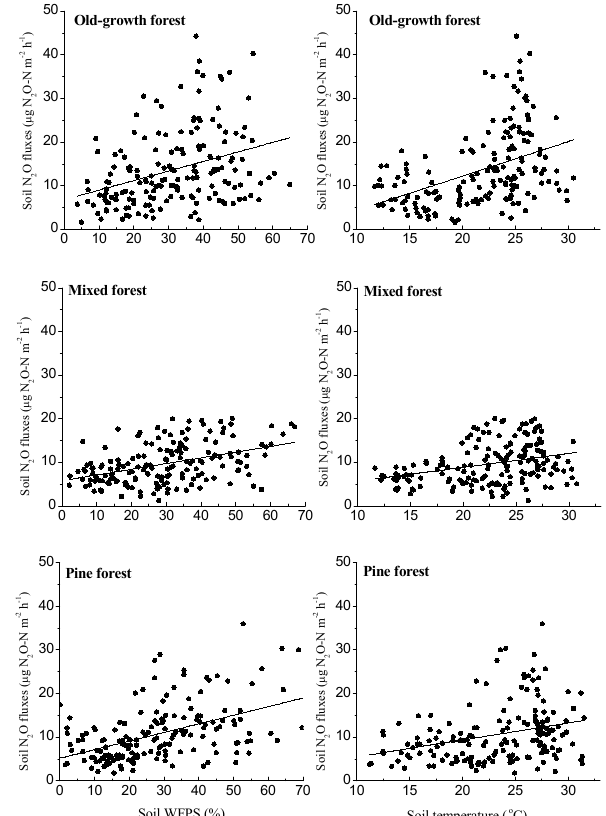
Figure 5. Relationships between N 2 O fluxes and soil WFPS (and temperature) in the five control plots of the study forests, as deter- mined by linear regression analyses. Coefficients of the regression lines are listed in Table